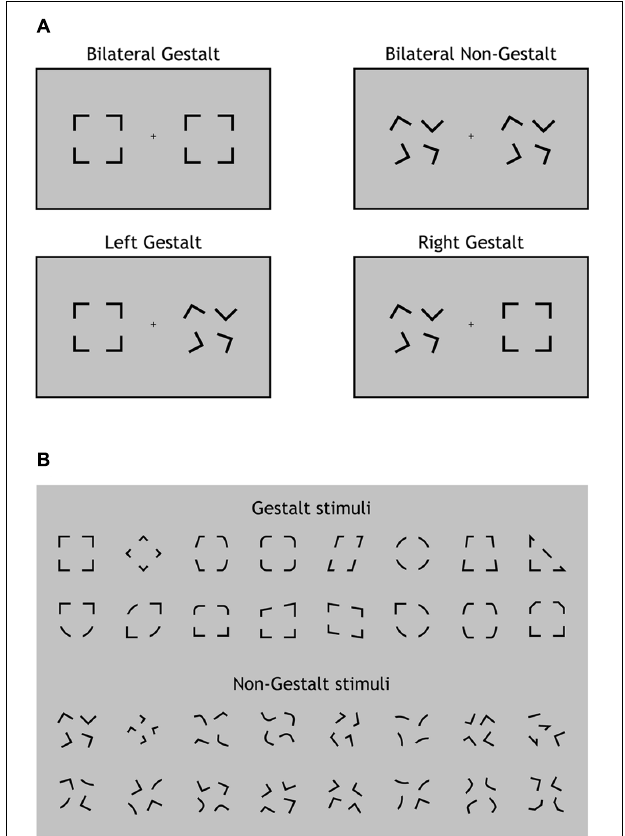
FIGURE 1 | Experimental design and stimuli. (A) The four types of visual displays used in this study. On each trial, visual stimuli were presented bilaterally (one per hemifield). A Gestalt stimulus configuration could be present for both stimuli (Bilateral Gestalt condition, GG ), for none of the stimuli (Bilateral Non-Gestalt, nn ), only for the left stimulus (Left Gestalt, Gn ), or only for the right stimulus (Right Gestalt, nG ). (B) The 16 different configurations used for Gestalt (top) and Non-Gestalt (bottom) stimuli throughout the